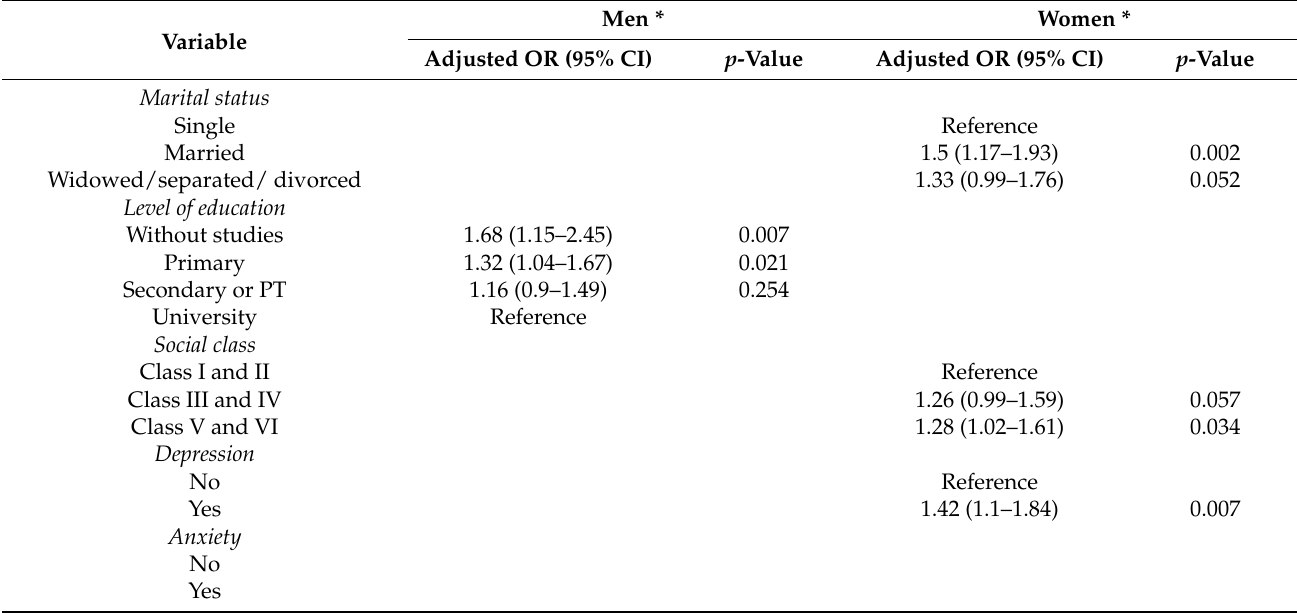
Table 5. Logistic regression model for the association between the low level of physical activity and sociodemographic and health characteristics stratified by